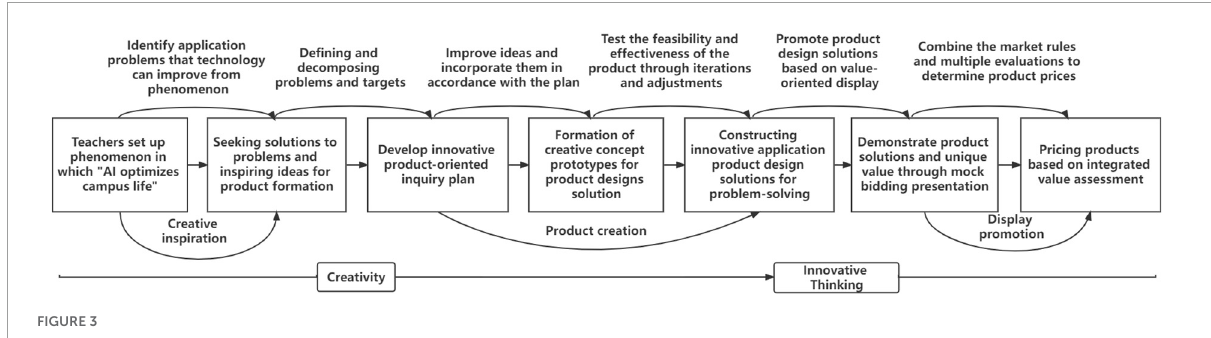
FIGURE3 Specific implementation path of the product-based pedagogy AI curriculum.